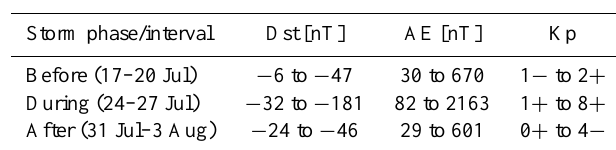
Table 3. Key parameters during the three highlighted time intervals in Fig.